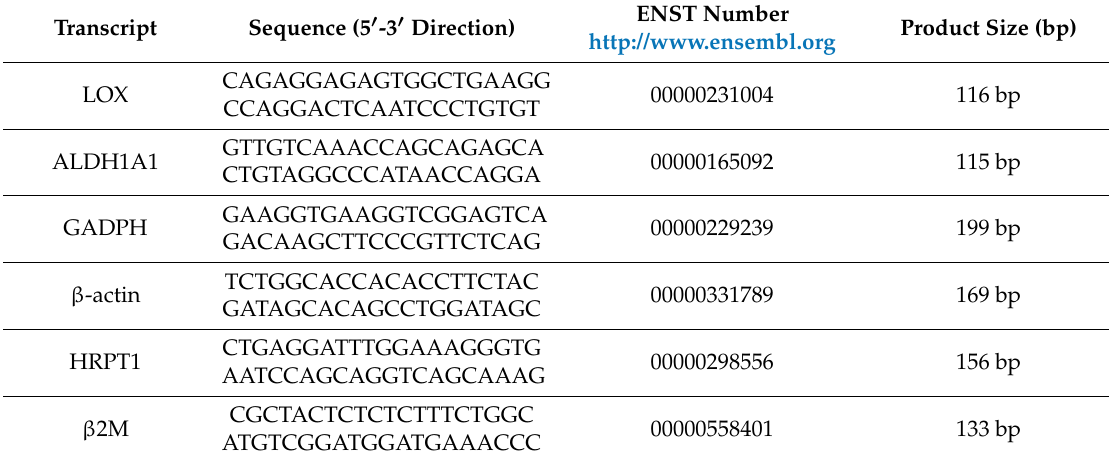
Table 1. Oligonucleotide sequences used for real-time quantitative RT-PCR (RQ-PCR)